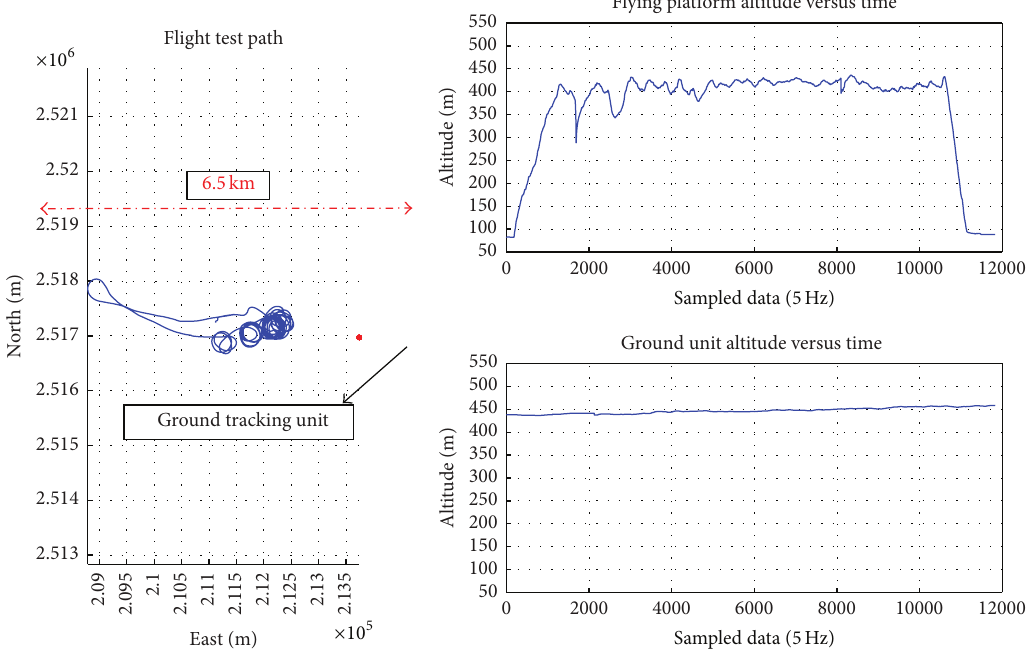
Figure 15: Flight test path and altitude.